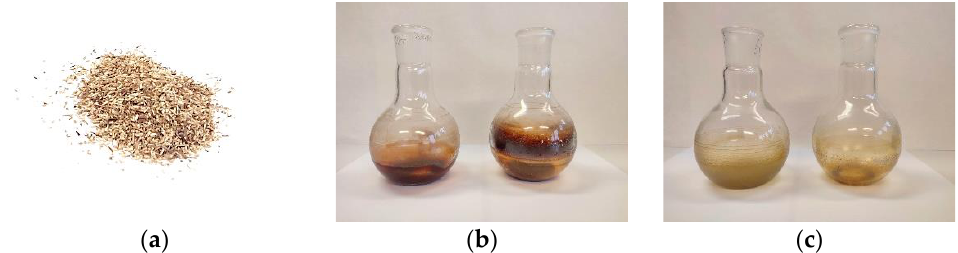
Figure 1. ( a ) Sample of sawdust from grape cuttings; ( b ) extract after water extraction (from the left: red and white grape); ( c ) extract after ethyl alcohol extraction (from the left: red and white grape)